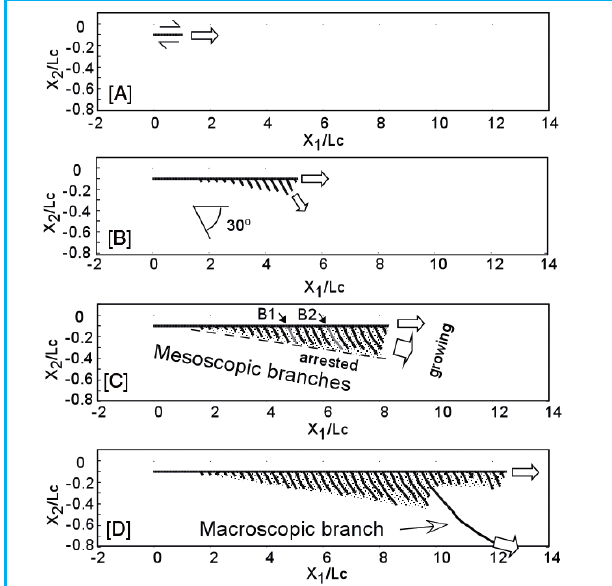
Figure 1. Schematic illustration of hierarchical structure of earthquake fault. Bottom (macroscopic scale): Scale of entire length of a fault system composed of planar segments; Middle (mesoscopic scale): length scale of fault zone involving damage zone (shaded) and branches; Top (microscopic scale): scale of frictional surface involving gouge and microcracks (after Ando and Yamashita,, 2007).